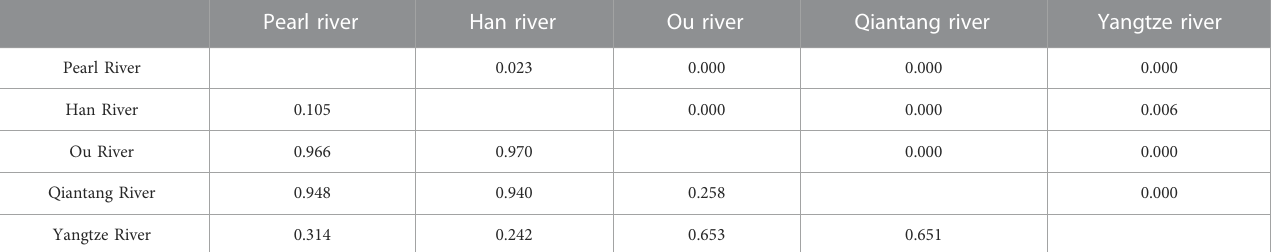
TABLE 2 Pairwise Φ ST values (below diagonal) and the corresponding Bonferroni-corrected p -values (above diagonal) among the fi ve drainages for S. parvus . The Jiaojiang River was excluded in this analysis, as only one specimen was collected in the drainage.